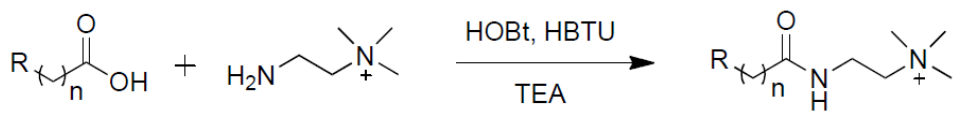
Scheme 2. Fatty acid labeling with isotopic cholamines gives improved electrospray ionization and allows for relative quantification (reagents: HOBt: hydroxybenzotriazole;